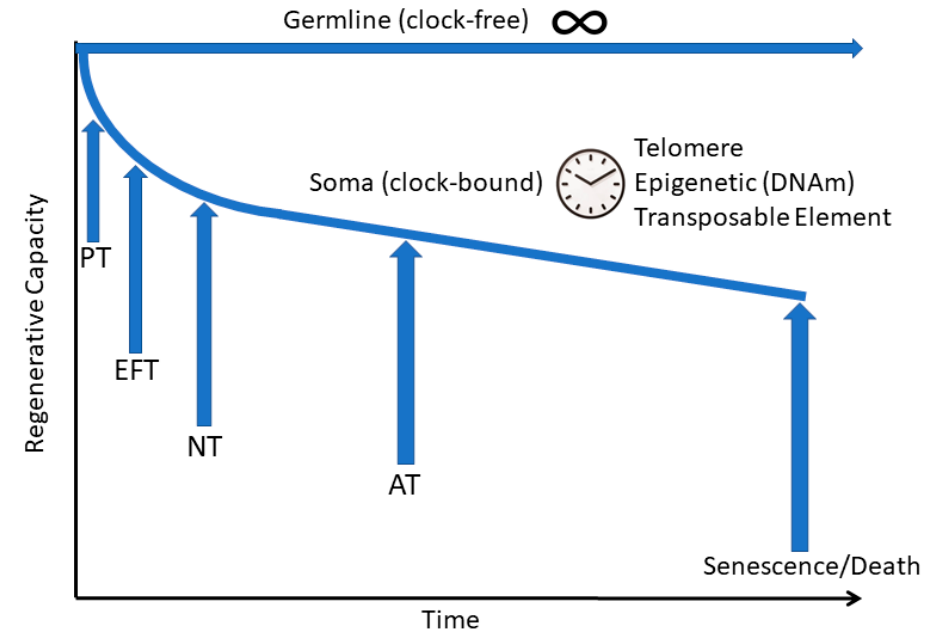
Figure 2. Somatic restriction model of regenerative capacity in germline versus somatic cells. The immortal germline is capable of indefinite replication (clock-free). In contrast, the cells of the body are clock-bound and therefore lose regenerative capacity as the cellular clocks (telomere, DNAm, and transposable element) tick forward soon after development starts and continue through a series of distinct transitions marked by changes in gene expression and epigenetic configuration of chromatin. PT, pluripotency transition; EFT, embryonic to fetal transition; NT, neonatal transition; AT, adult transition.